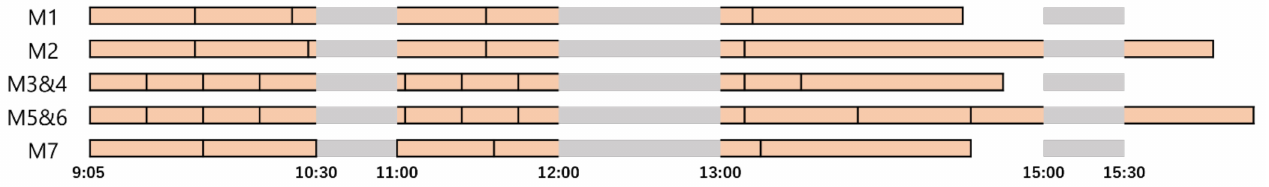
Figure 6. Weighting factor is ( w 1 , w 2 ) = (0.5,